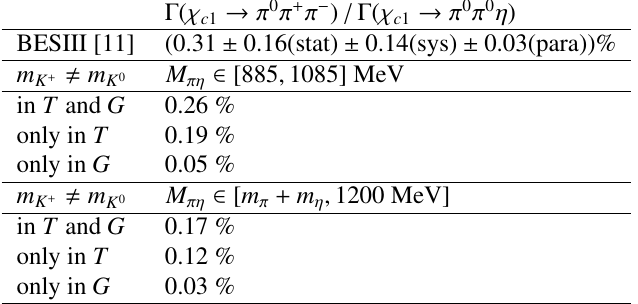
Table 1. Comparison between experiment and theoretical results for the a 0 (980) − f 0 (980) mixing in the χ c 1 → π 0 π + π − and χ c 1 → π 0 π 0 η